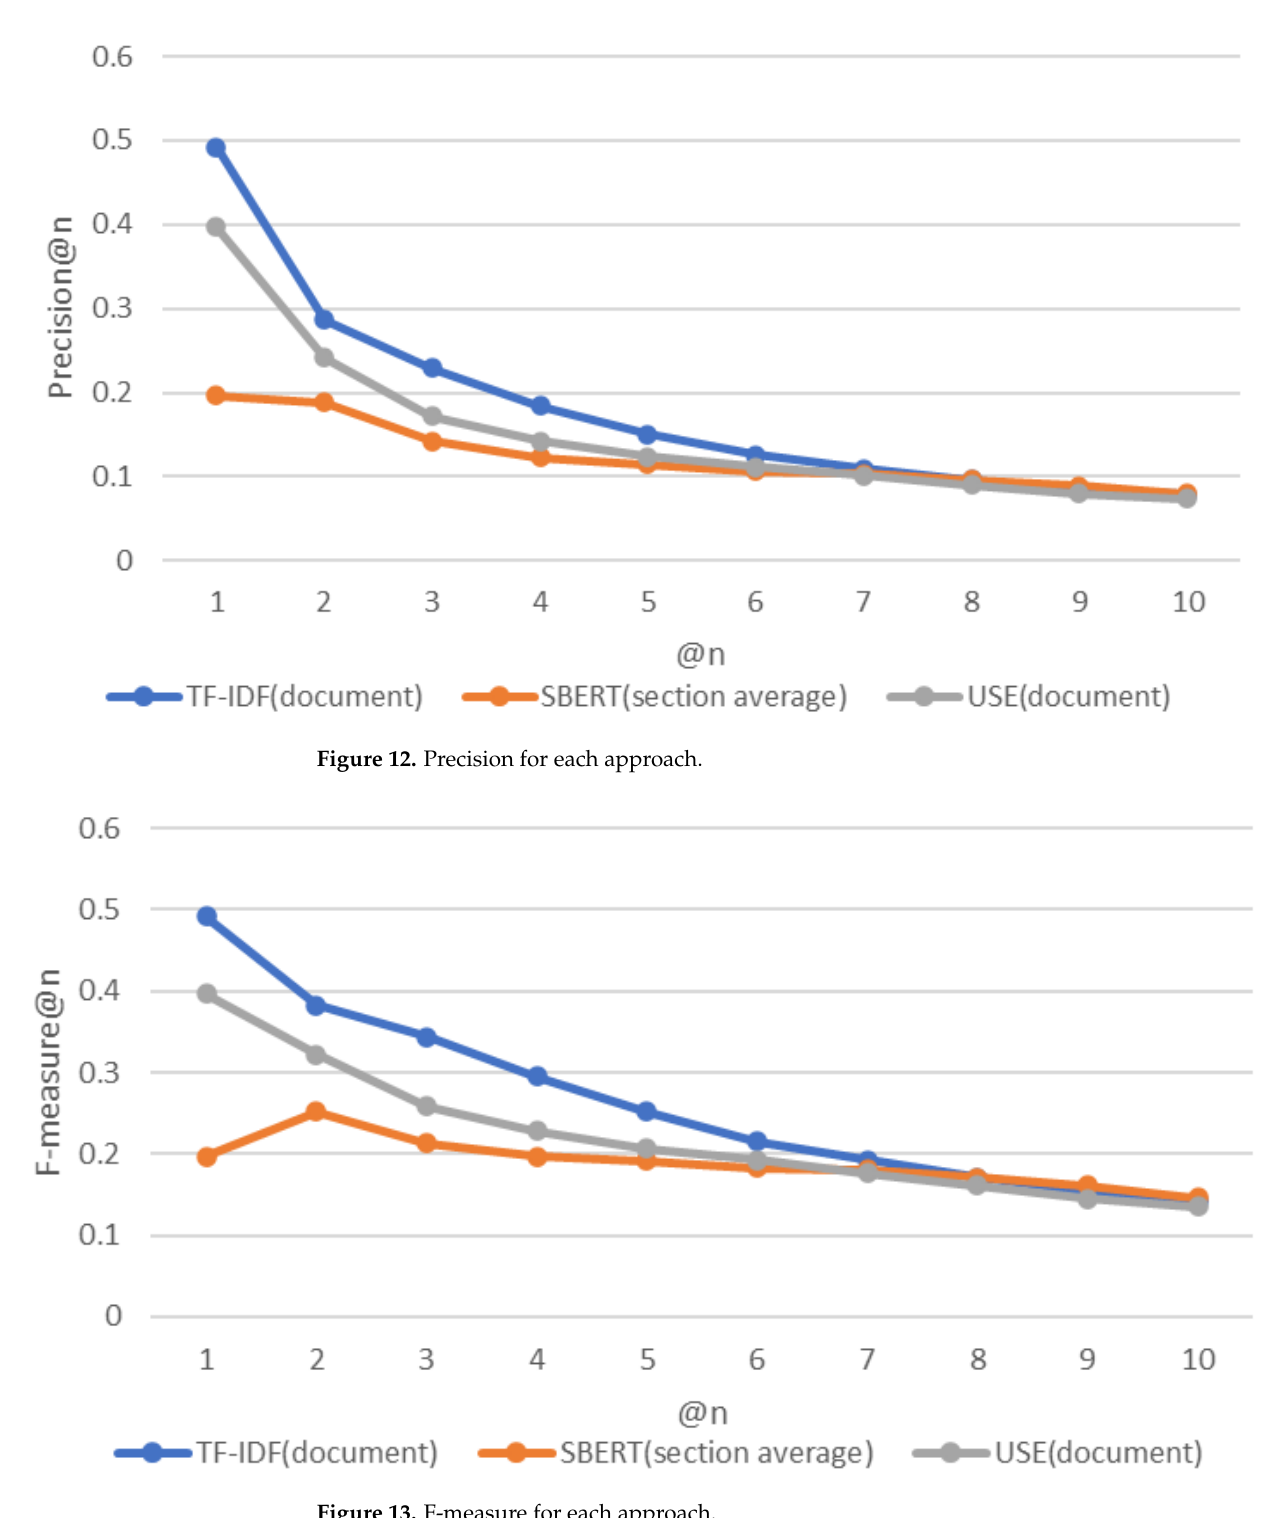
Figure 11. Recall for each approach.